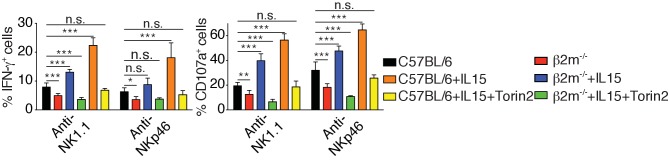
Percentage (mean +SD) of IFN-γ or CD107a positive cells among splenic NK cells from C57BL/6 or B2m−/− mice following 4 hr stimulation with coated anti-NK1.1 or anti-NKp46 in the presence or absence of 10 ng/ml IL-15 and 250 nM Torin2 as indicated (n = 4 mice of each genotype in two independent experiments, one-way ANOVA comparing each condition to the C57BL/6 condition, *p<0.05, **p<0.01, ***p<0.001, n.s. non significant).